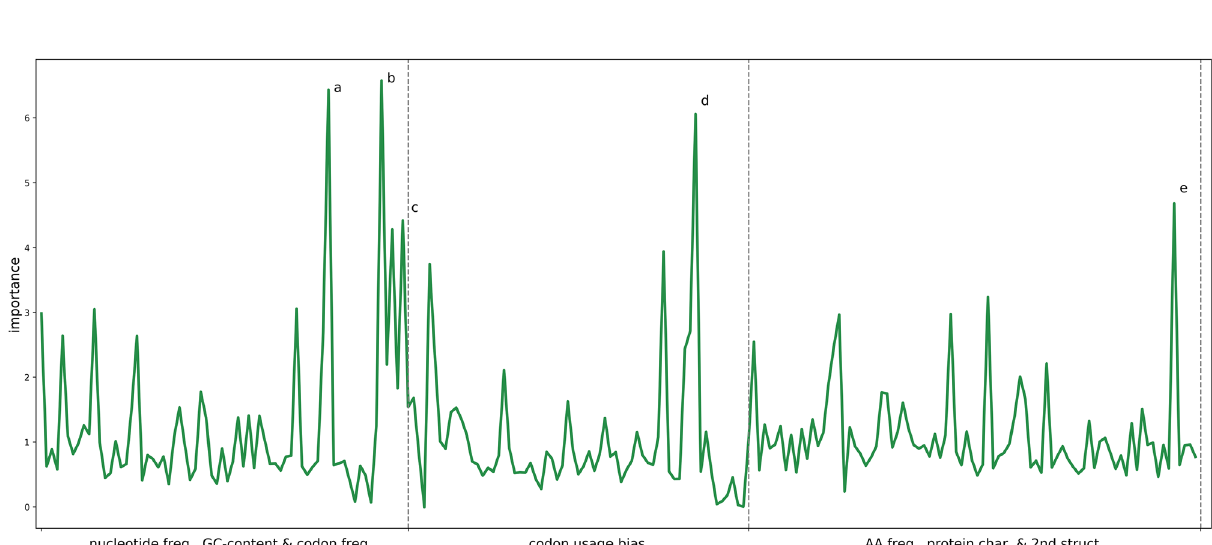
Figure 6. Plot of feature importance of a Random Forest (RF) model trained on all data with all features. An RF model was trained on all data with all features in Scikit-learn (version 0.22.1, https ://sciki t-learn .org/). The feature importance attribute was plotted. Five features influence predictions the most: (a) A nucleotide frequency, (b) TTA codon frequency, (c) TTA codon usage bias, (d) the first Z-scale descriptor and (e) GC